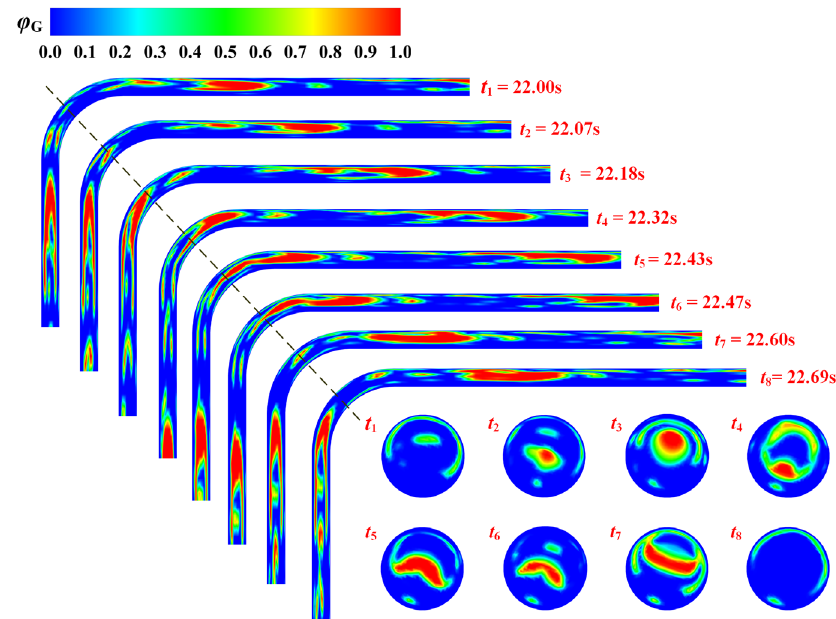
Figure 8. The evolution of gas–liquid two-phase flow through Bend 2 and the associated gas volume fraction in the B-B cross-section in the case of Q G eight representative moments. denotes